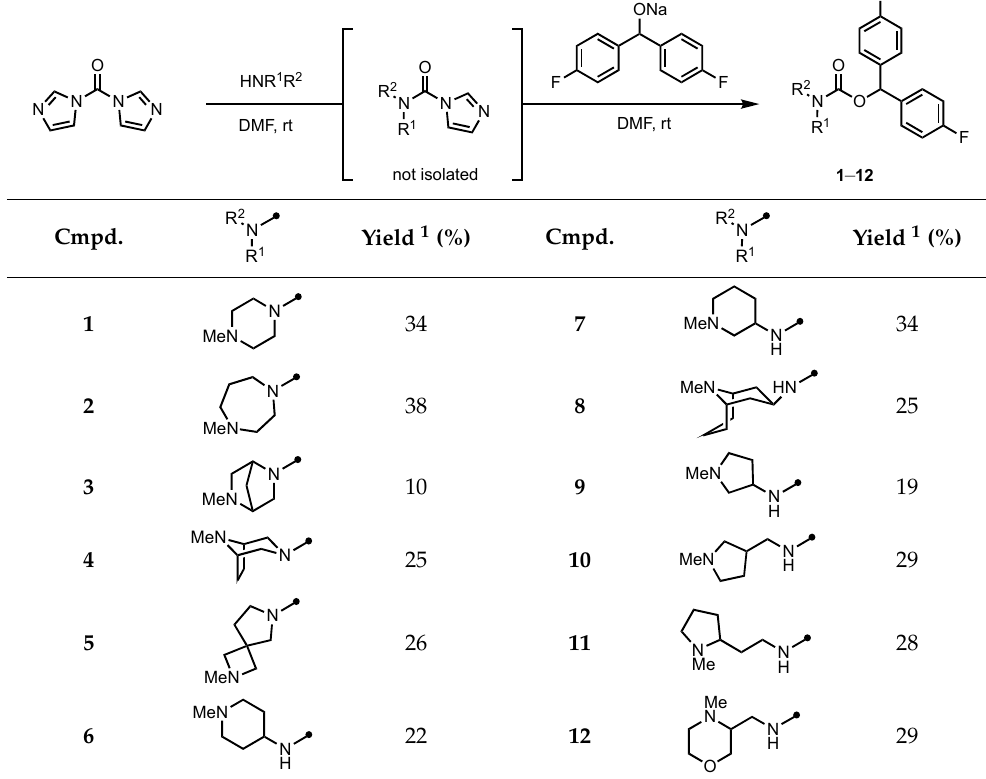
Cmpd. Cmpd. Cmpd. Cmpd. Cmpd.